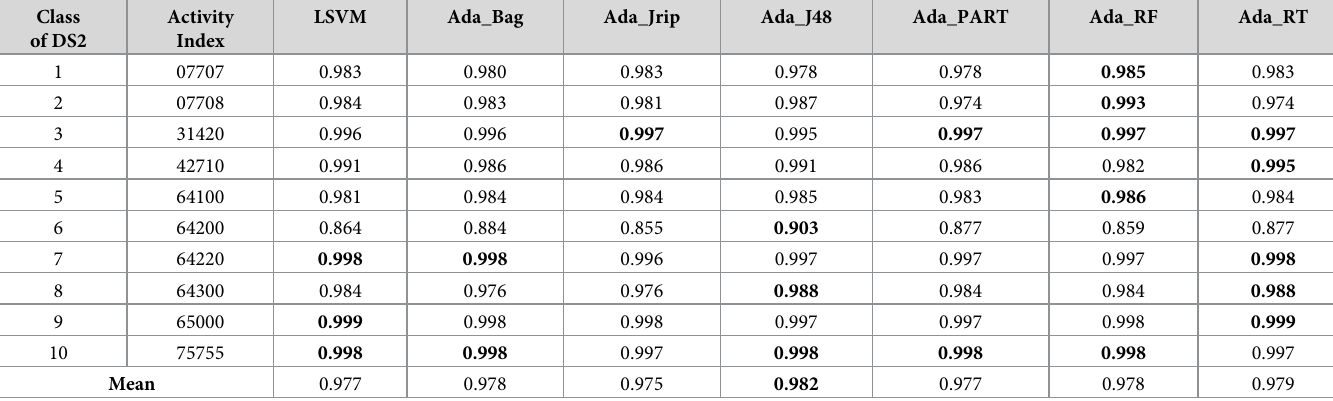
Table 11. AUC measure for the prediction of new bioactive molecules with DS2